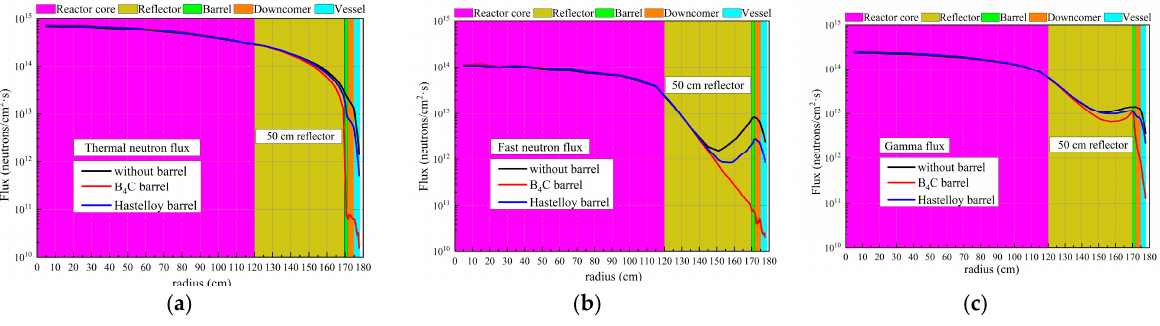
Figure 2. The radial ( a ) thermal neutron, ( b ) fast neutron and ( c ) gamma flux under different barrel materials when the thickness of reflector is 50 cm.